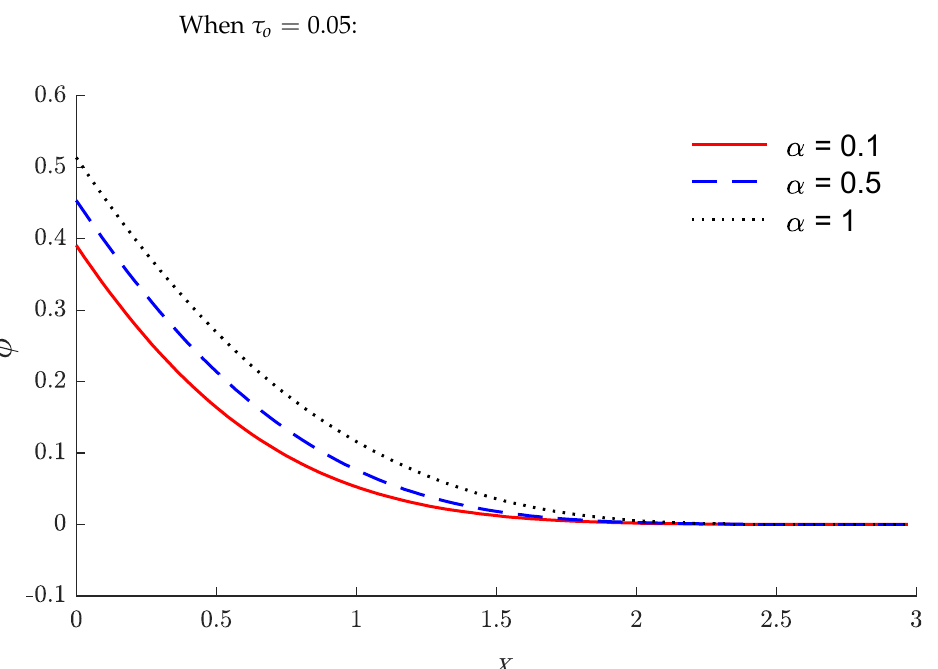
Figure 3. The displacement distributions via the distance 𝑥 for three values of fractional parame- ters. When 𝜏 (cid:3042) = 0.05 :